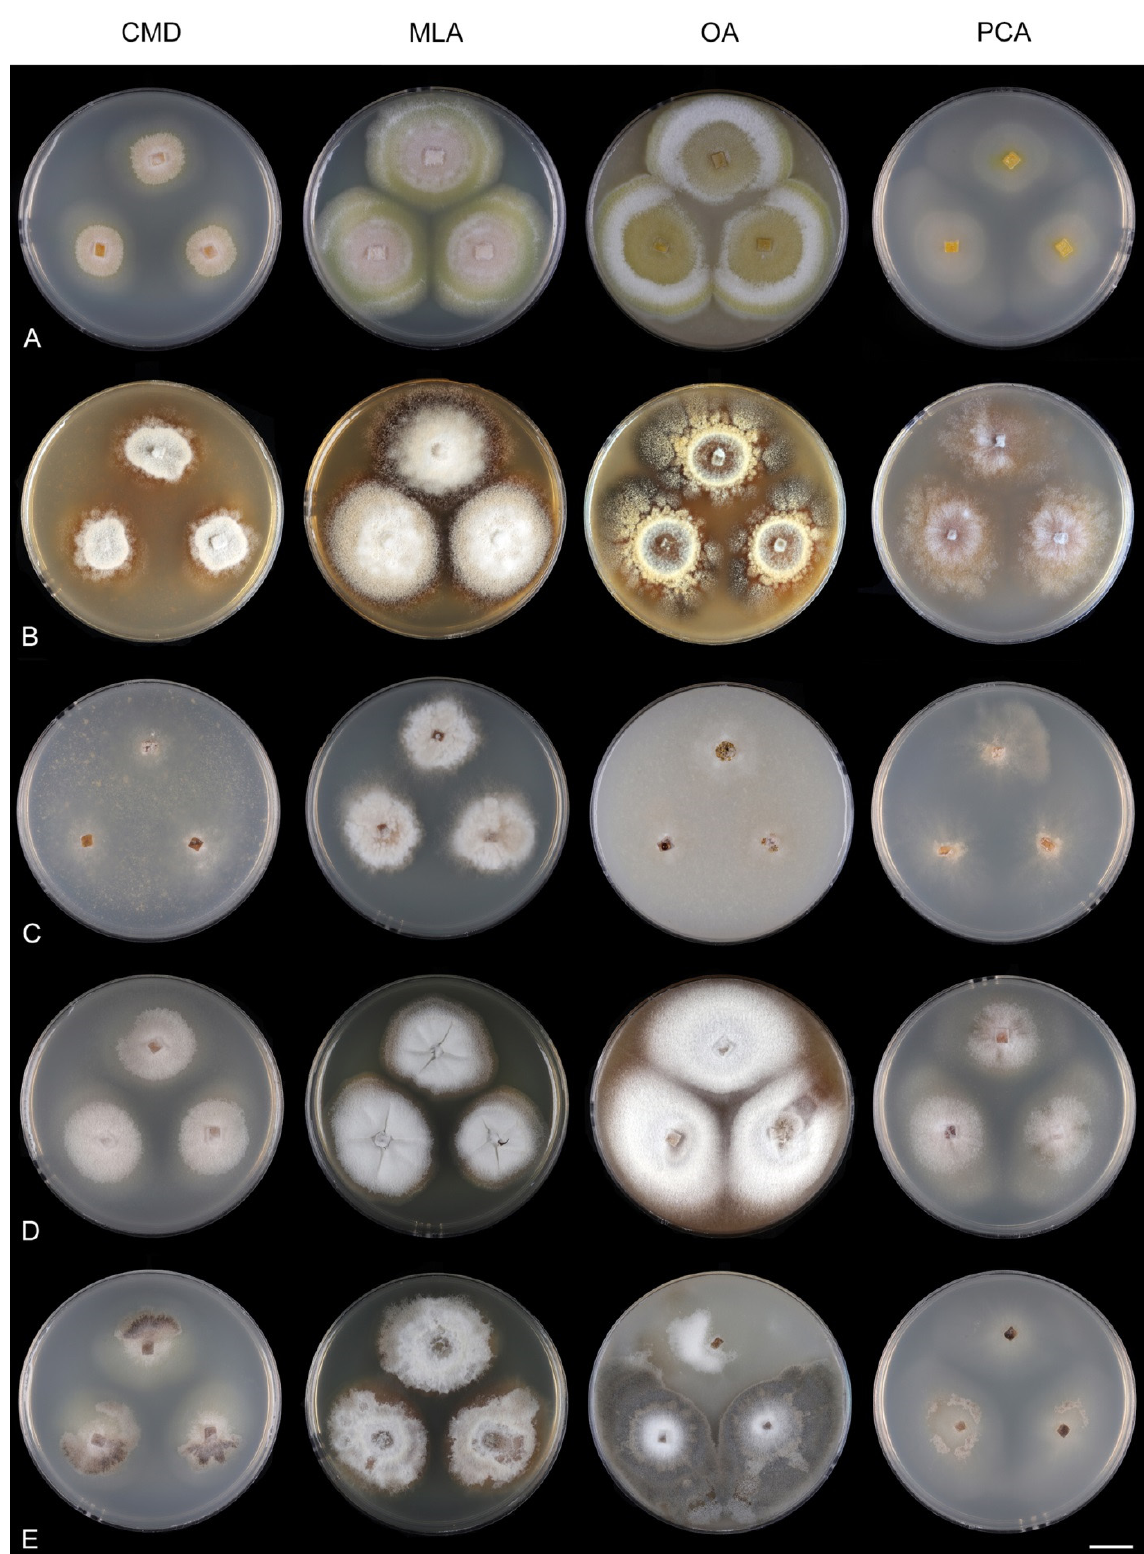
Figure 34. Colony morphology of Stilbochaeta spp. after 4 weeks. ( A ) S. aquatica CBS 114070 ( B ) S. malaysiana IMI 312436 ex-type ( C ) S. ramulosetula IMI 313452 ex-epitype ( D ) S. septata CBS 143386 ex-epitype ( E ) S. septata CBS 146716. Scale bar: ( A – E ) 1 cm.